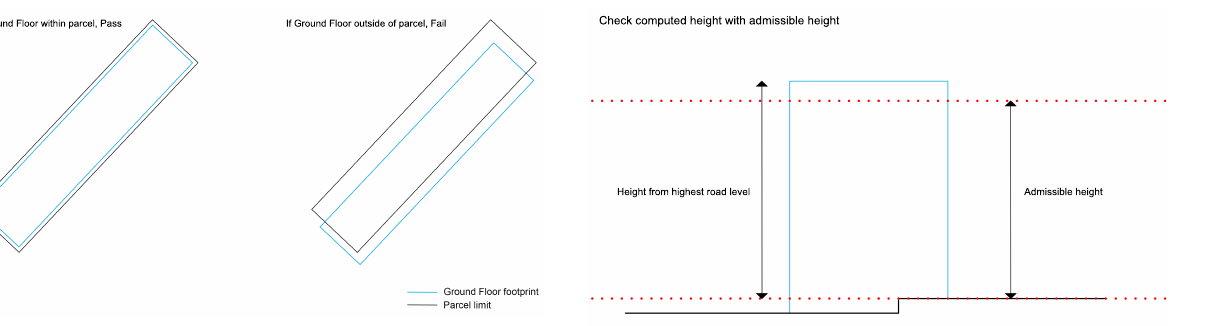
Figure 3. Compare computed height to admissible height (Figure 3c). The normal of each vertical side of the OBB is computed and is checked against the adjacent roads (Figures